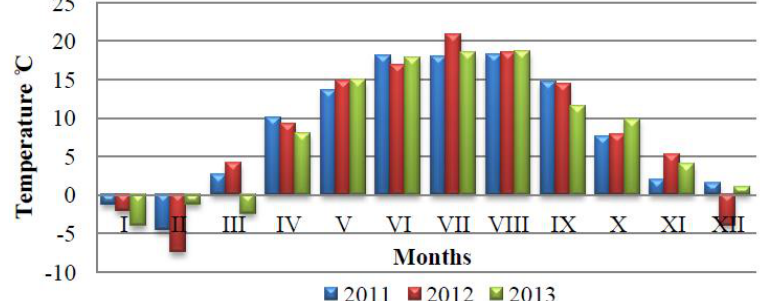
Figure 6. Average monthly temperatures for Radawiec near Lublin, Poland, in the years 2011–2013 [23].